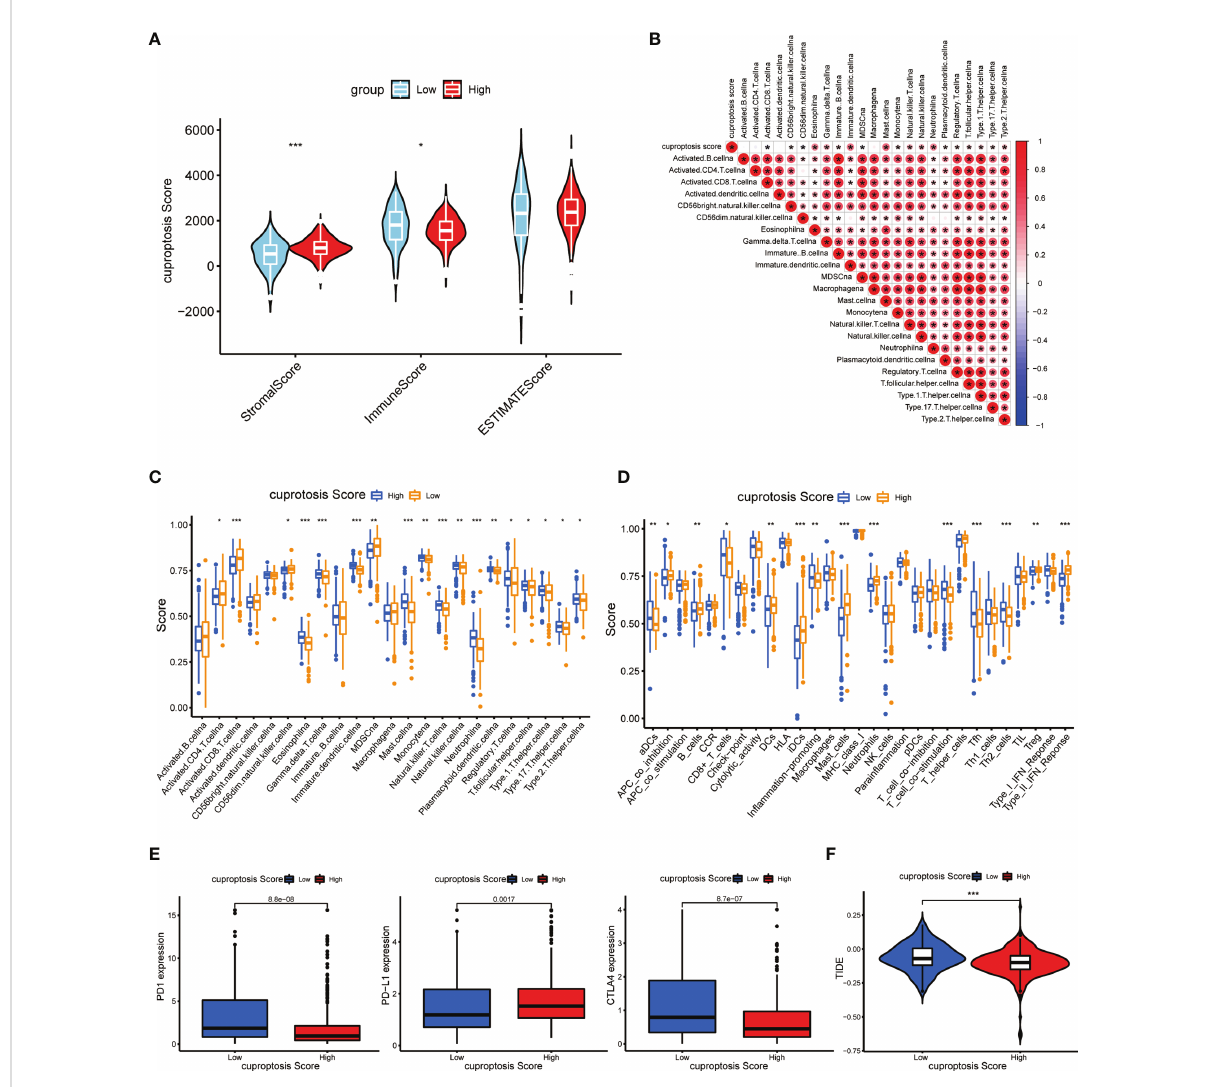
FIGURE 9 Immune and immunotherapeutic correlation of cuproptosis score. (A) Tumor purity of patients with high and low cuproptosis score. (B) Correlations between immune-related cells and cuproptosis score. (C, D) Abundance of immune cell in fi ltration (C) and immune-related functions (D) in patients with high and low cuproptosis scores. (E) Abundance of immunotherapy markers in patients with high and low cuproptosis scores. (F) TIDE in different cuproptosis score groups ( p < 0.05 *; p < 0.01 **; p < 0.001 ***. NS, not signi fi